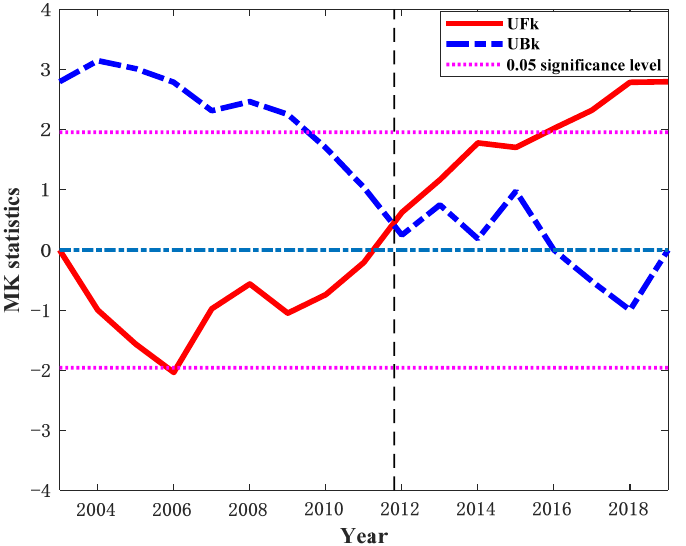
Figure 8. Mutation points detected by the Mann–Kendall (MK) trend test method. The UF k and UB k are two statistics calculated based on the MK trend test method.